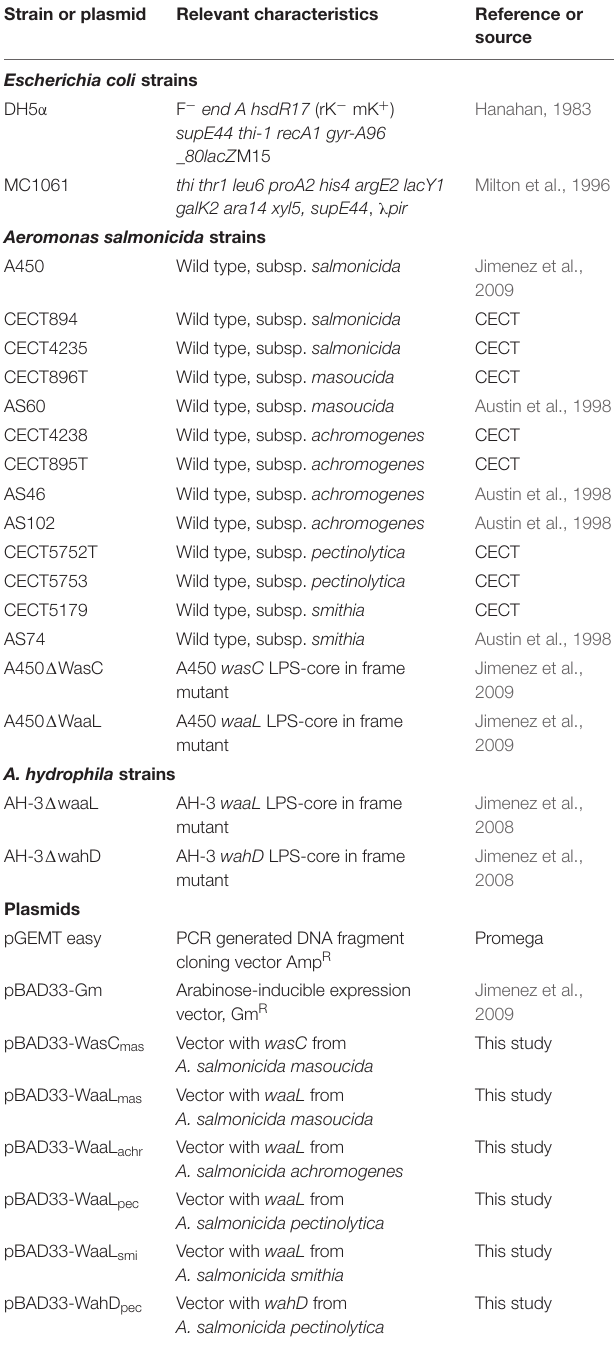
TABLE 1 | Bacterial strains and plasmids